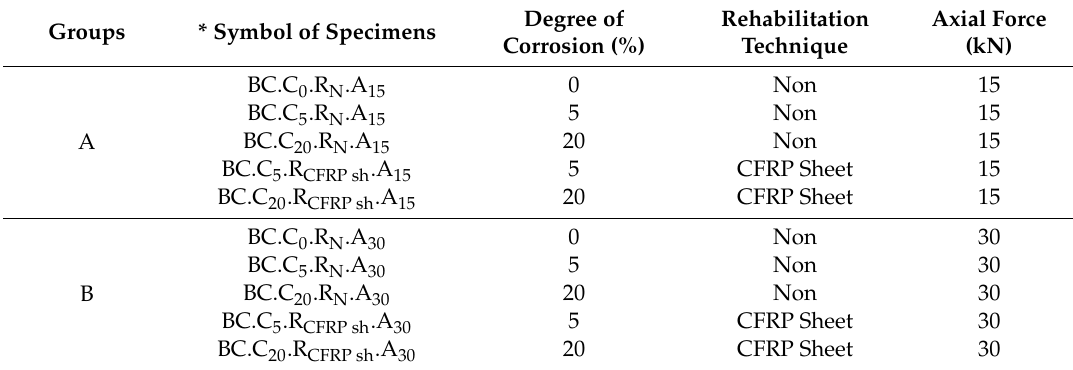
Table 1. Designation and details of tested